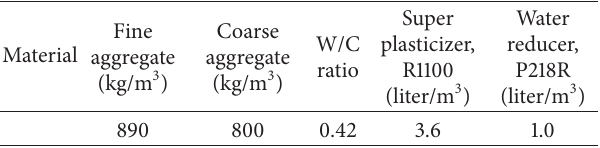
Table 1: Concrete mix proportion.